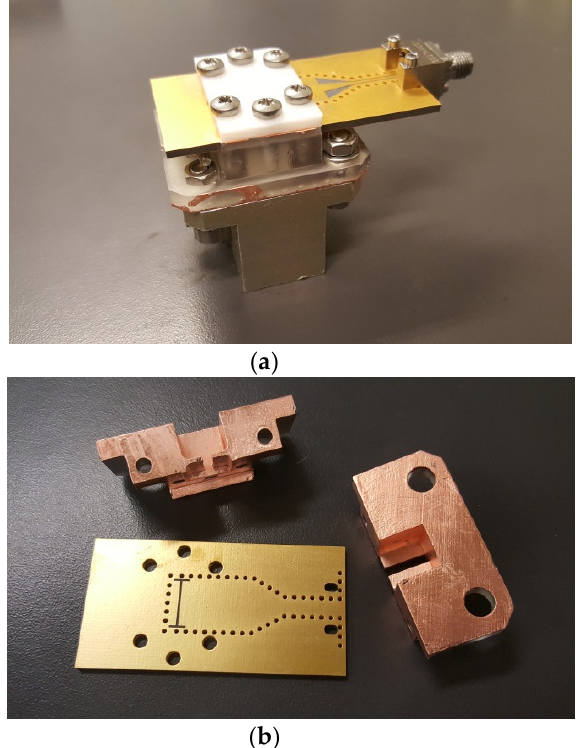
Figure 11. RWG-to-SIW transition prototype. ( a ) Assembled structure; ( b ) Matching networks details. PCB size is 29 × 56 mm.